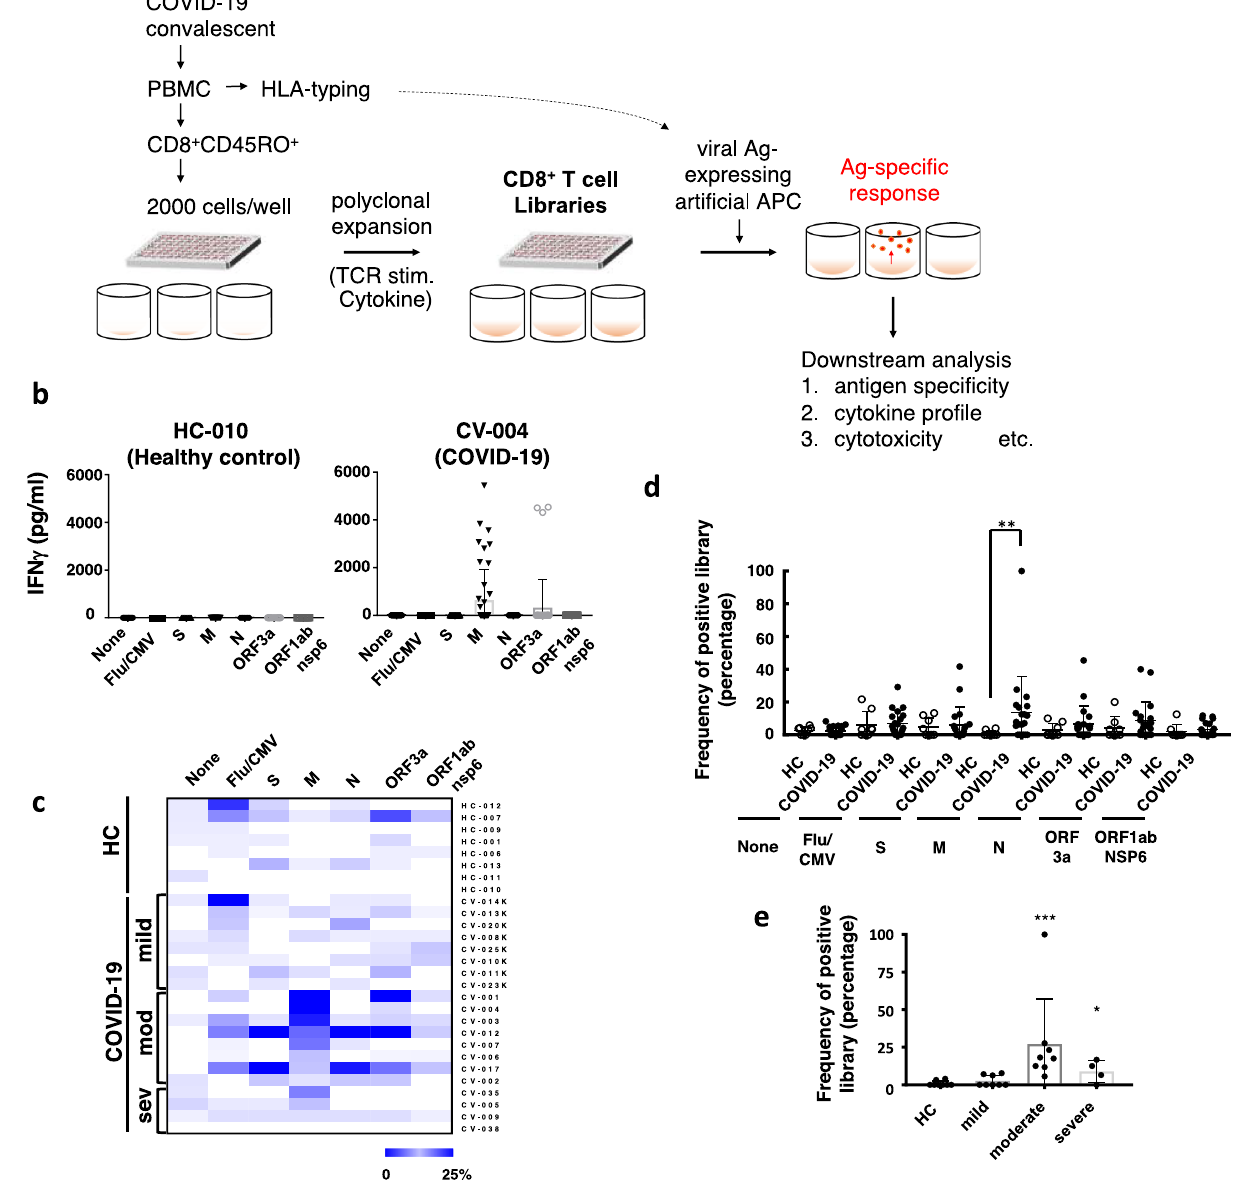
Fig. 1 | Cellular screening of SARS-CoV-2-speci fi c response. a Memory CD8 + T cells (CD45RO + ) from peripheral blood mononuclear cells (PBMC) of COVID-19 convalescents were seeded at 2000 cells/well in multiple wells containing irra- diated allogenic PBMC, PHA, IL-2, IL-7, and IL-15 as described in Methods. The individual cultures were expanded to make up the libraries of polyclonally ampli- fi ed CD8 + T cells. Then the libraries were washed and examined as to their antigen speci fi citybystimulatingwithaseriesofviralprotein-expressingaAPC.Oncebeing judged as positive by IFN γ level (measured by ELISA), they were further expanded with relevant aAPC and cytokines. These libraries (cell lines) were subjected to several downstream analyses including epitope screening, cytokine pro fi ling, and/ orcytotoxicityassays,etc. b ArepresentativeresultoftheCD8 + Tcelllibraryassay. Libraries from a healthy donor (HC-010) or COVID-19 convalescent (CV-004) were divided into 7 groups, and each group was co-cultured with indicated aAPCs: S ( n =15 for HC-010; n =47 for CV-004), M ( n =15 for HC-010; n =47 for CV-004), N ( n =15forHC-010; n =47forCV-004),ORF3a( n =14forHC-010; n =41forCV-004), orORF1abNSP6( n =14forHC-010; n =53forCV-004)-expressingaAPCs,in fl uenza virusandcytomegalovirus(Flu/CMV)derivedpeptides( n =15forHC-010; n =47for